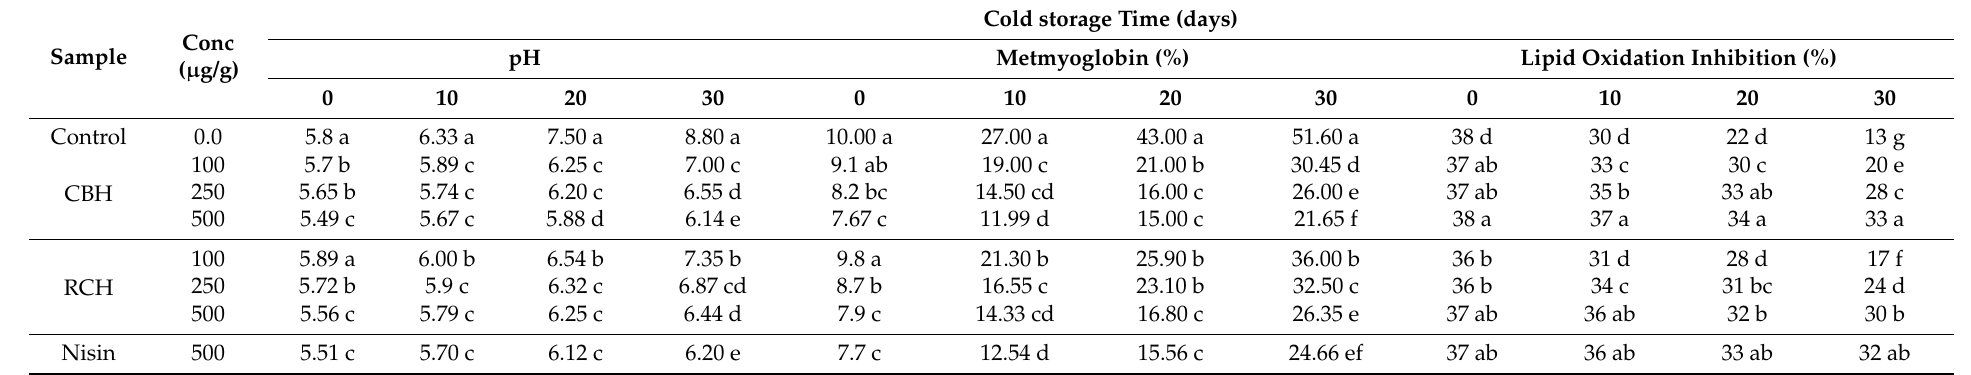
Means with different lowercase letters in the same column indicate significant